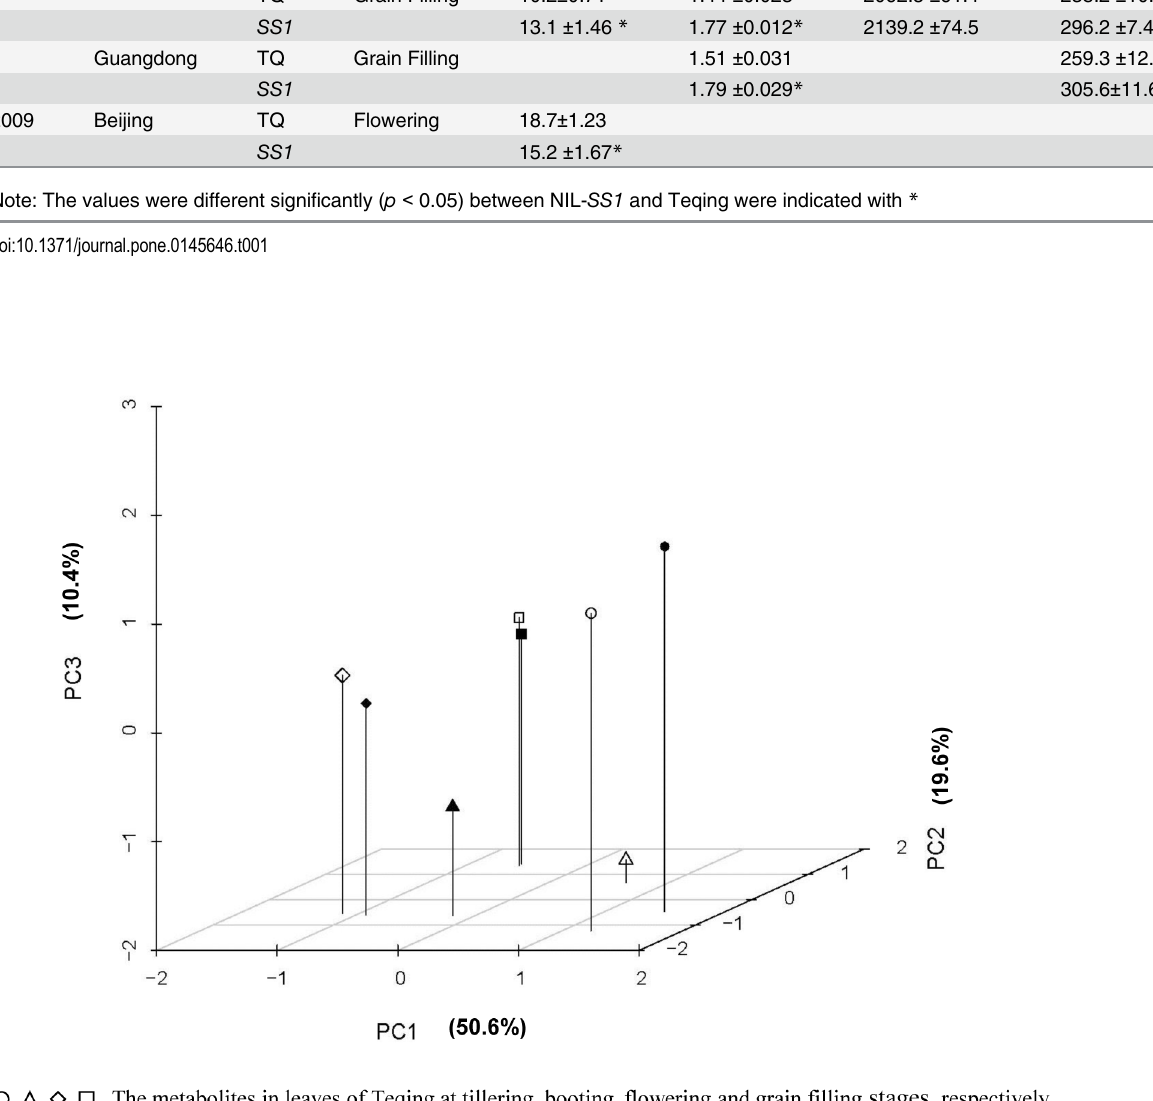
Fig 1. Principal component analysis (PCA) for metabolites in leaves of NIL- SS1 and Teqing at the tillering, booting, flowering and grain filling